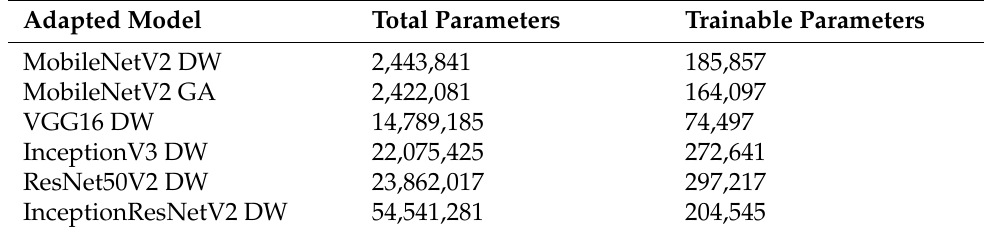
Table 1. Number of parameters for each of the adapted models.